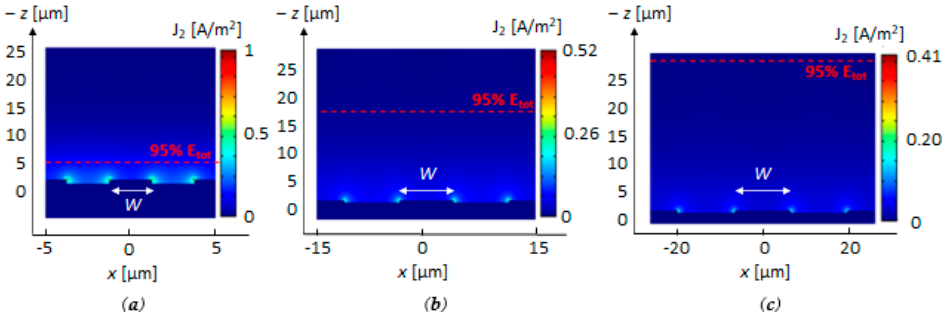
Figure 5. Current density J 2 [A/m 2 ] distribution in the IME structures with a value of width W = G of 5 µm ( a ), 15 µm ( b ), and 25 µm ( c ). The current values have been normalized to the maximum value of current calculated for W = 5 µm. The dotted red line represents the distance from the electrodes, where 95% of the total energy is confined. Plots calculated by 2D FEM approach.